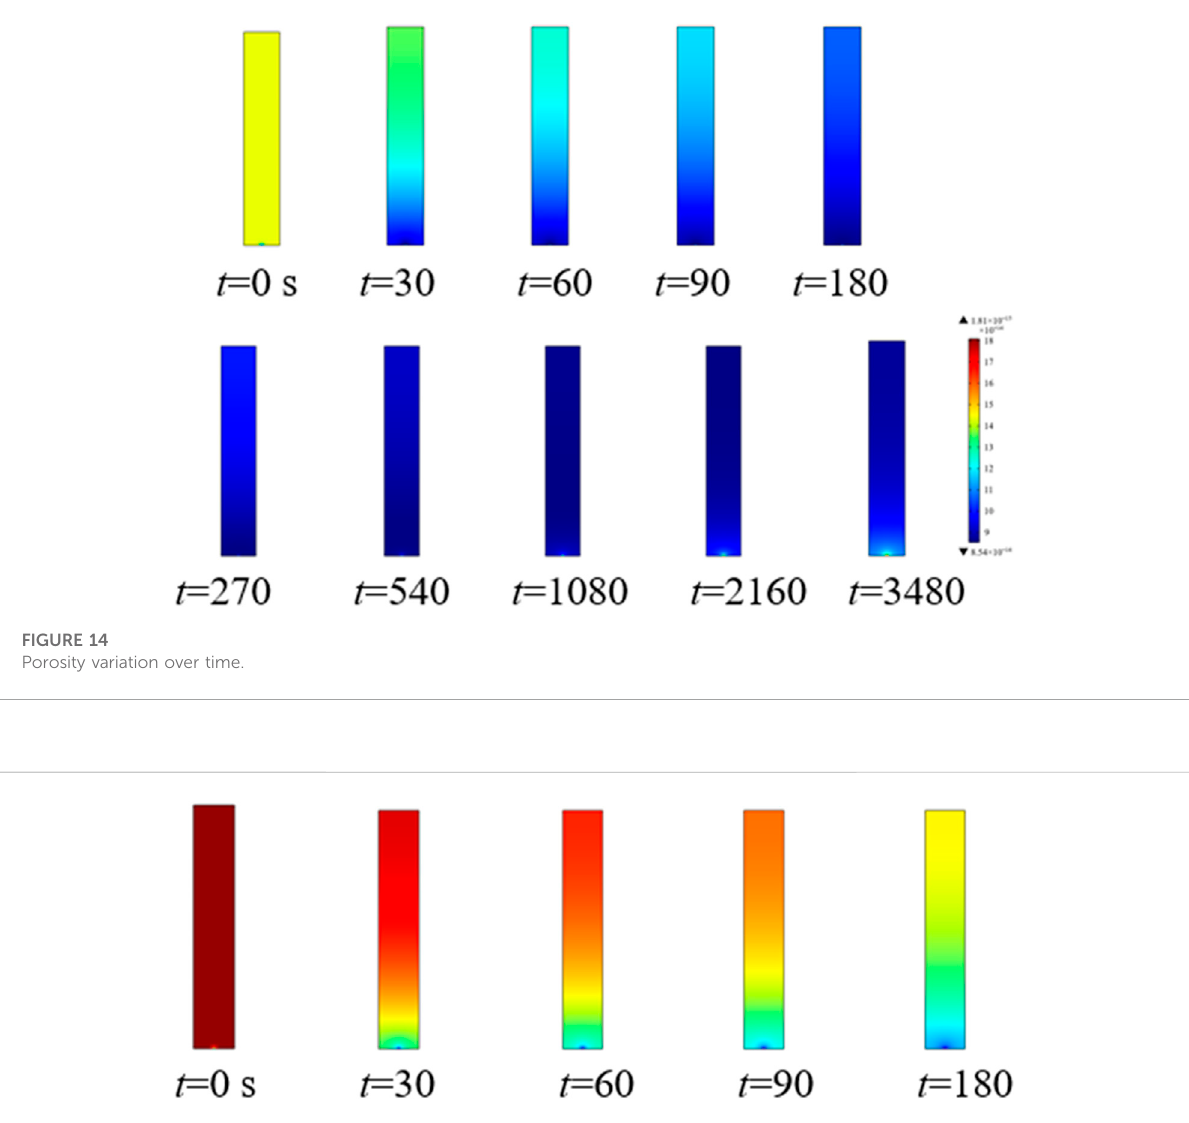
FIGURE 15 Pore pressure variation over